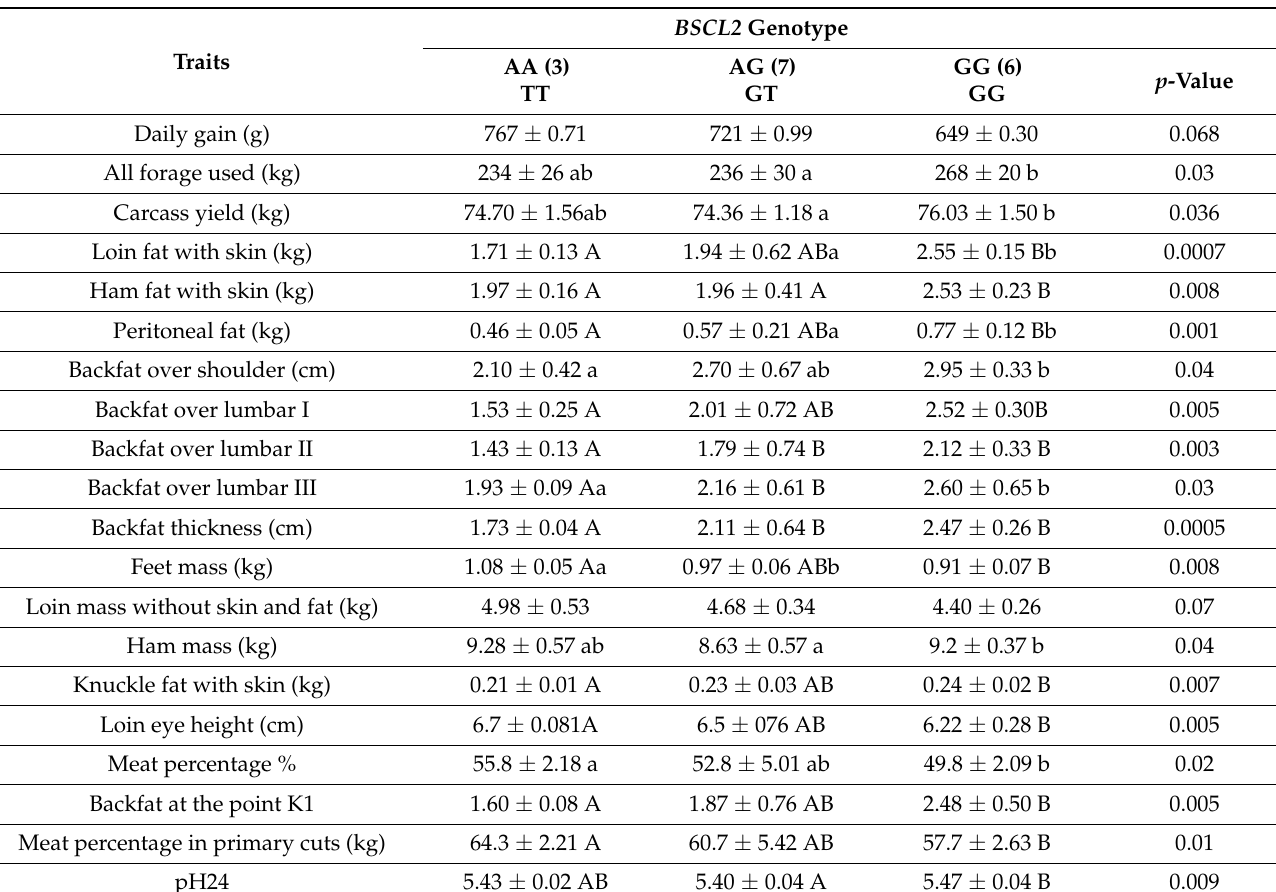
Table 2. Means with standard deviation (SD), calculated based on ANOVA test (SAS) for pig production traits dependent on rs341493267 and rs346079334 BSCL2 variants, for 16 Złotnicka White pigs included in RNA sequencing analysis.